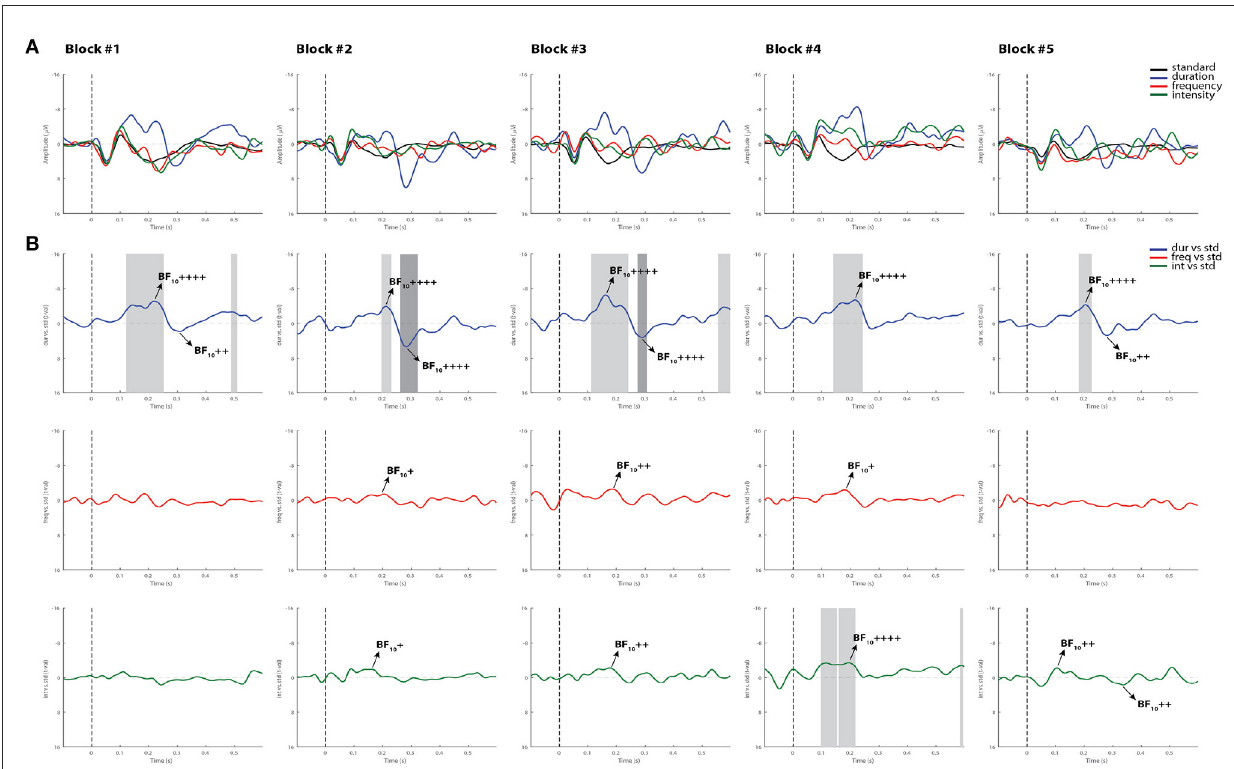
FIGURE5 Individual ERPs and statistical findings of a representative control subject with the lowest MMN detection rate. (A) Individual ERPs across blocks. (B) Time course of the difference between deviants and standard stimuli expressed in units of t -values. Significant intervals for negative components are denoted by a light gray area, and those for positive components are denoted by a dark gray area. Black arrows show the latency of maximum Bayes factors and the strength of evidence for H 1: +, anecdotal; ++, moderate; +++, strong; ++++, very strong to